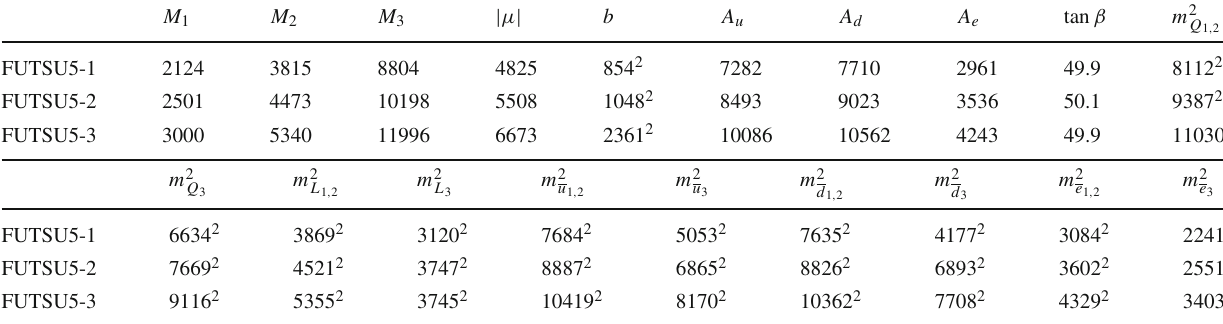
Table 4 Finite N = 1 SU ( 5 ) predictions that are used as input to SPheno . Mass parameters are in GeV and rounded to 1 GeV M 1